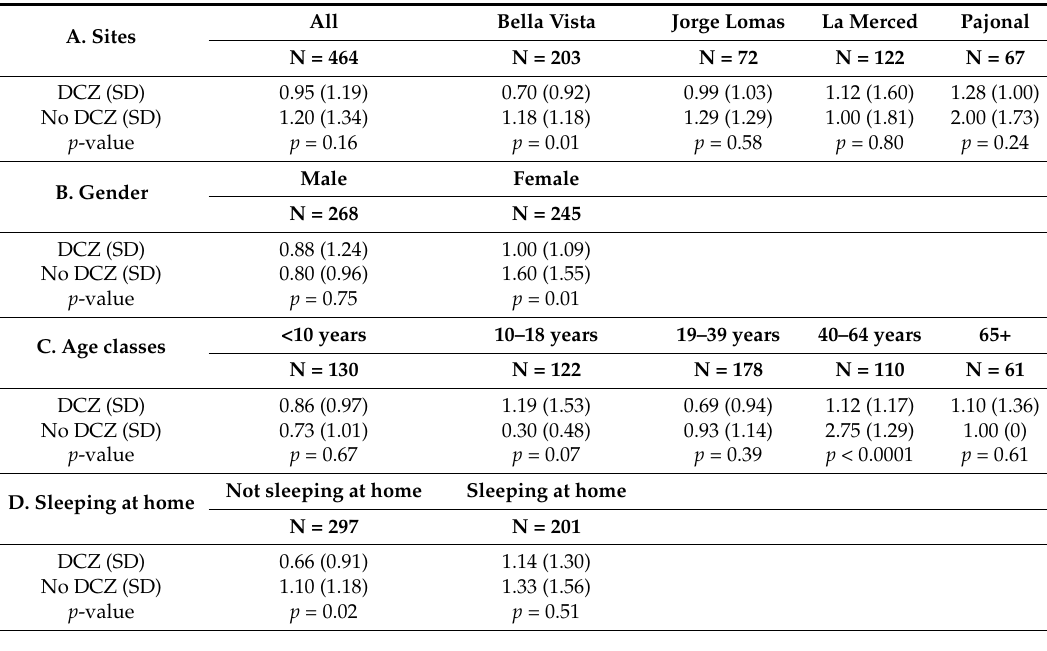
Table 5. Distress symptoms reported by participants with versus without suspected dengue, chikungunya, Zika fever (DCZ) infections following the earthquake. Means and standard deviations (SD) shown. Significant differences indicated by p <